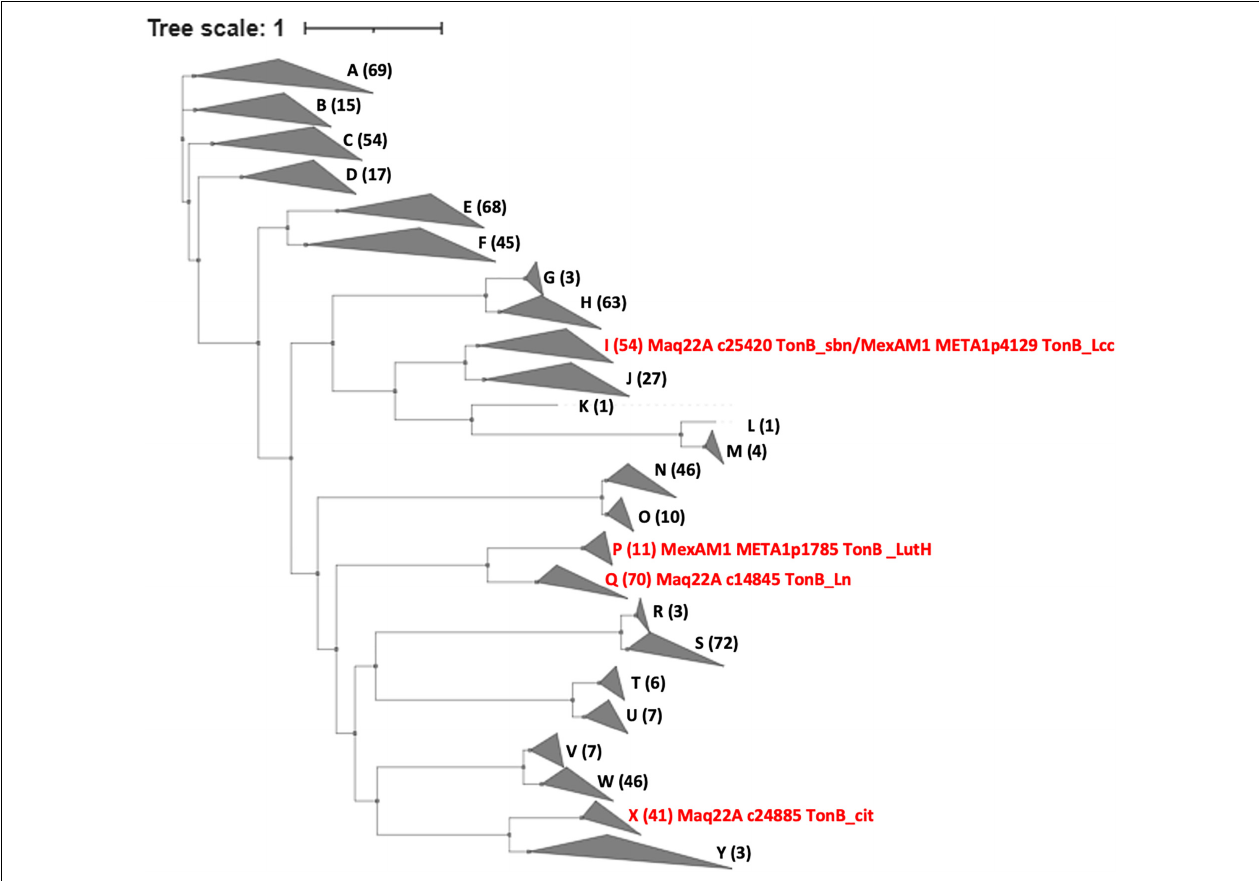
FIGURE 7 | Phylogenetic tree and gene counts of TBDRs found in the genomes of different subclades of Methylobacterium type strains. The phylogenetic tree is constructed based on the amino acid sequences of TBDR genes. The Methylobacterium subclade definition is based on our previous report (Alessa et al., 2021). A total of 25 clades are labeled A-Y. The counts of TBDRs and description of characterized TBDRs are indicated in brackets. Details are presented in Supplementary Table 3